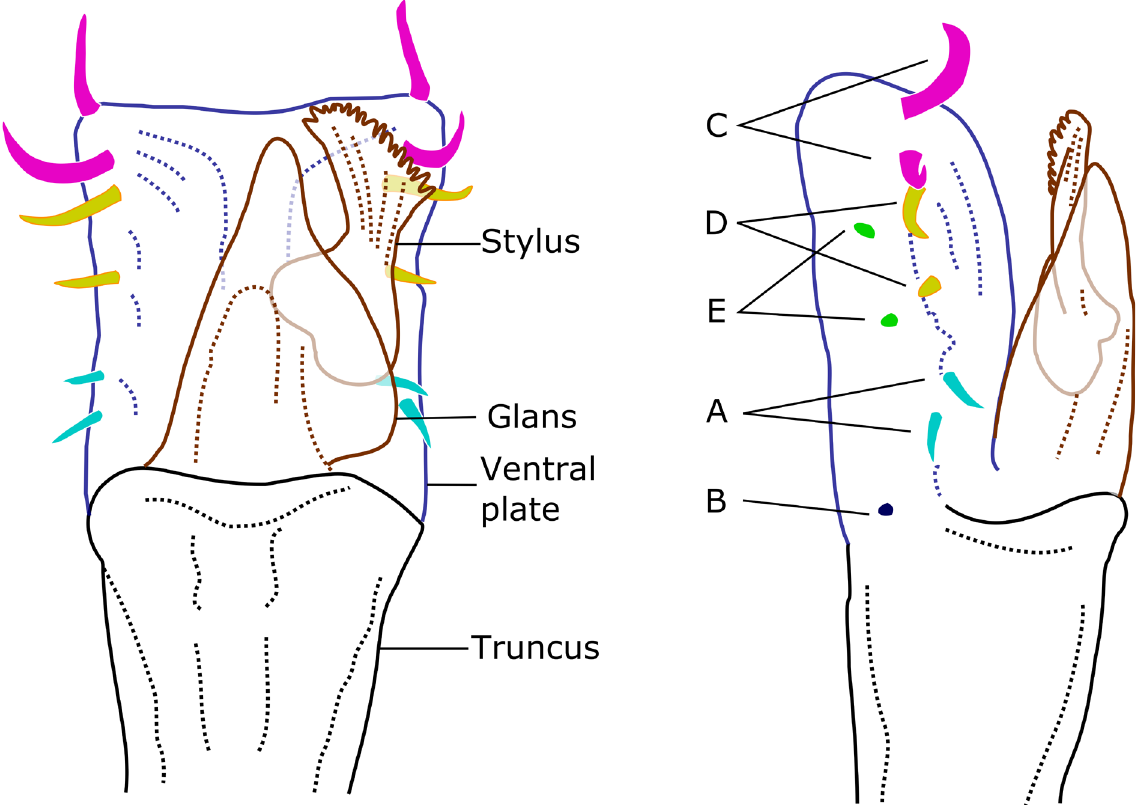
Fig. 3. Penis of Eulibitia maculata Roewer, 1912 (ICN-AO 875), dorsal and lateral view (from left to right) showing parts and interpretation of macrosetae, labeled with letters